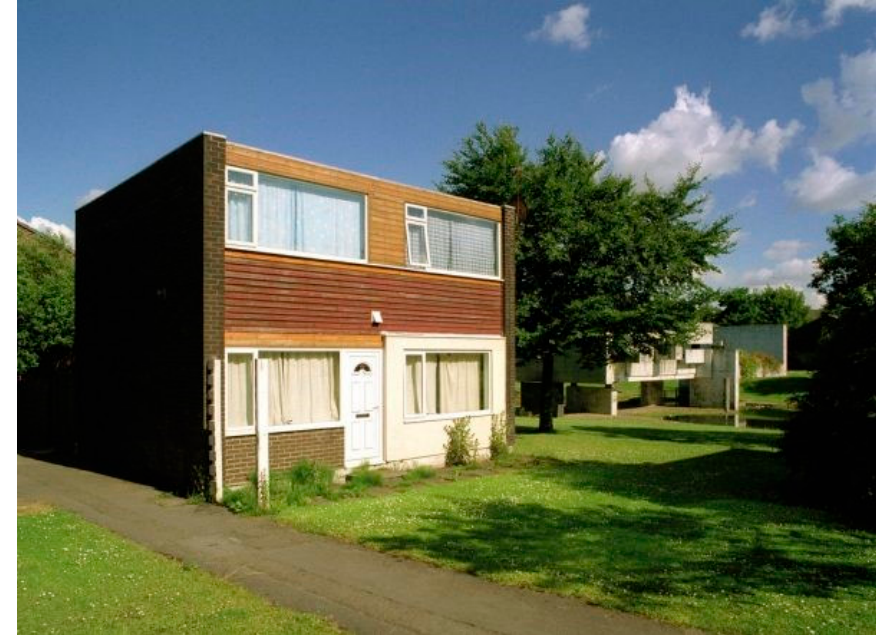
Figure 3. Sally Ann Norman, from Farewell Squalor , 2003. © Sally-Ann Norman, reproduced with kind permission of Sally-Ann Norman Photography. 6